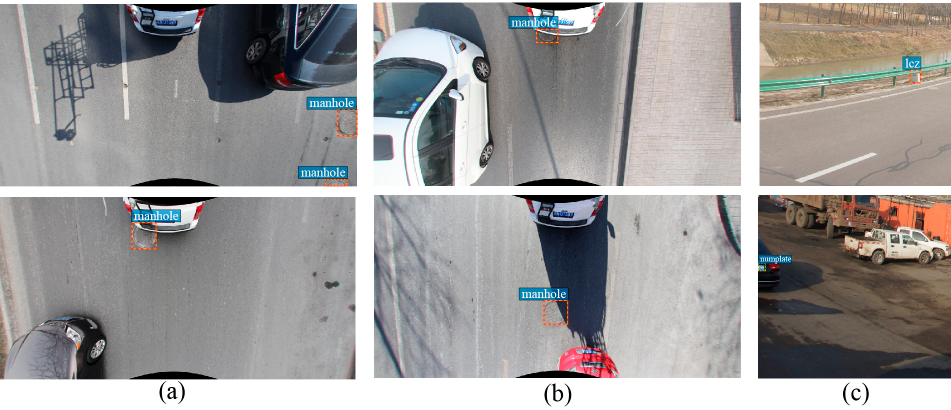
Figure 10. Performance with varying degrees of occlusion. ( a ) and ( b ) are for manhole covers; ( c ) is for milestones (top) and